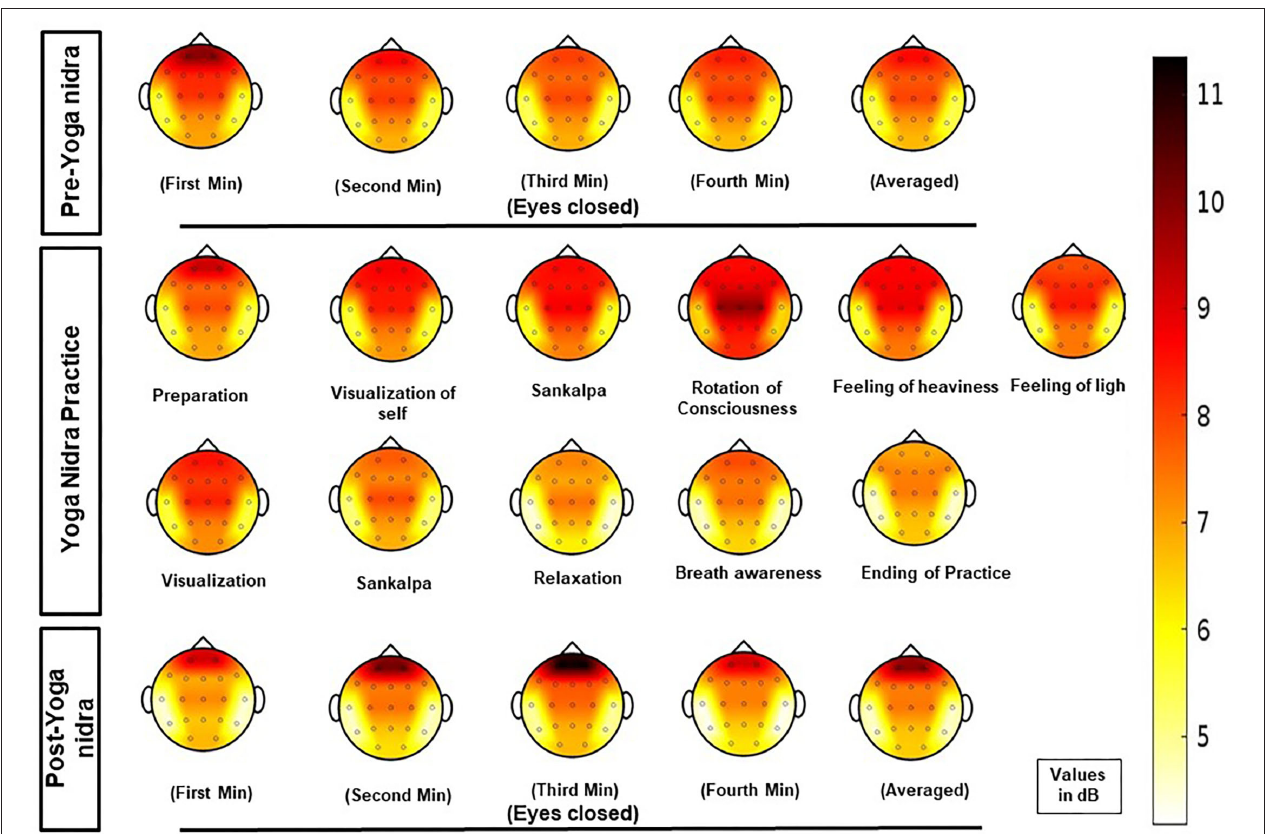
FIGURE 2 | Topo plots of mean power spectral density (PSD) values of delta frequency band at all regions (pre-frontal, frontal, central, parietal, temporal, and occipital) during the yoga nidra recording session, i.e., pre-yoga nidra (just before the practice), during yoga nidra practice and post-yoga nidra (just after the practice).